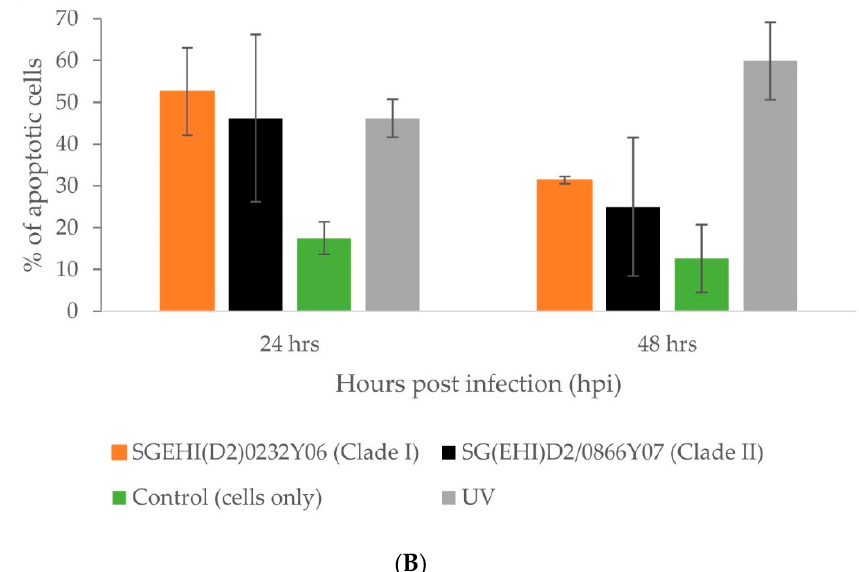
Figure 4. Apoptotic profiles of K562 cells infected by DENV − 2 isolates. Cells infected with clade I and II isolates (M.O.I. = 5) were collected at 24 and 48 hpi, stained with Annexin-V/PI and analyzed using flow cytometer ( A ). Dot plots show the apoptotic profiles of a representative set of K562 cells at 24 hpi ( a – d ) and 48 hpi ( e – h ). Lower left quadrant represents cells negative for both Annexin-V and PI. Lower right quadrant represents Annexin-V-positive cells (early apoptotic cells). Upper left quadrant represents PI-positive, but Annexin-V-negative cells. Upper right quadrant represents cells positive for Annexin-V and PI (necrotic cells). Clade I (SGEHI(D2)0232Y06) is shown in panels ( a , e ). Clade II (SG(EHI)D2/0866Y07) is shown in panels ( b , f ). Cells alone ( c , g ) and cells subjected to UV treatment ( d , h ) were included as negative and positive controls, respectively. The data are from a single experiment performed using technical triplicates. The mean percentage of cells stained/non-stained with Annexin-V and/or PI among the total number of cells used in triplicates are shown in the quadrants of each panel. ( B ) Percentage of apoptotic cells. The data show the cumulative values of upper (Annexin-V-positive necrotic cells) and lower (early apoptotic cells) right quadrants of each panel in ( A ). The differences are not significant between clade I (SGEHI(D2)0232Y06) and clade II (SG(EHI)D2/0866Y07) isolates at 24 and 48 hpi. Error bars indicate ± S.D.